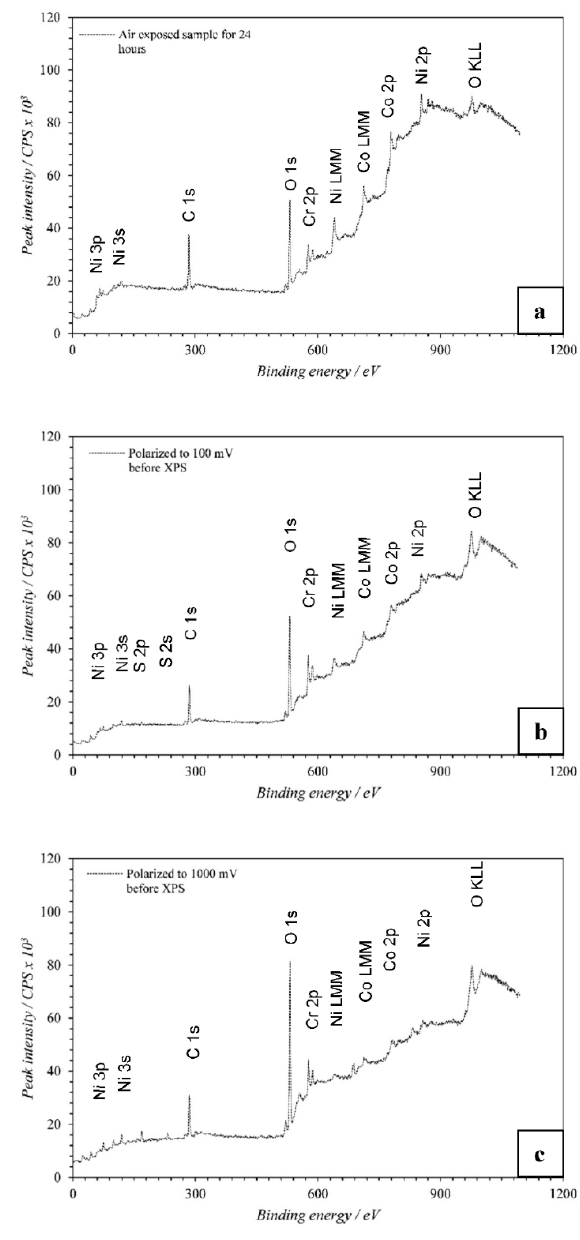
Figure 12. XPS survey spectra, ( a ) air exposed sample for 24 h, ( b ) sample polarized to 100 mV, ( c ) sample polarized to 1000 mV before XPS scan.